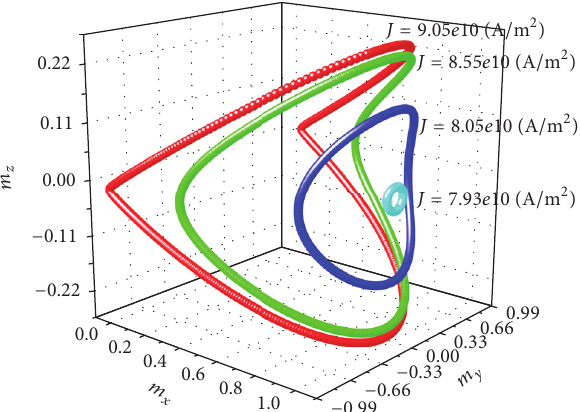
Figure 4: Magnetization oscillating trajectory with different current densities for in-plane free layer with initial state 𝑚 𝑥 ≈ 1 . Higher current density leads to oscillation with larger cone angle and finally switching. The free layer size is 40 nm × 20 nm × 1.5 nm, with 𝐽 = 9.05 × 10 10 A/m 2 . 7.93 × 10 10 A/m 2 and 𝐽 sw